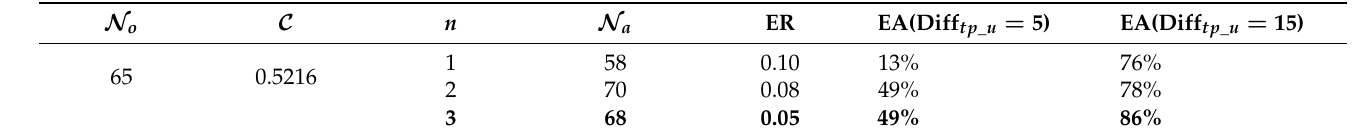
Table 3. Estimation results of data set